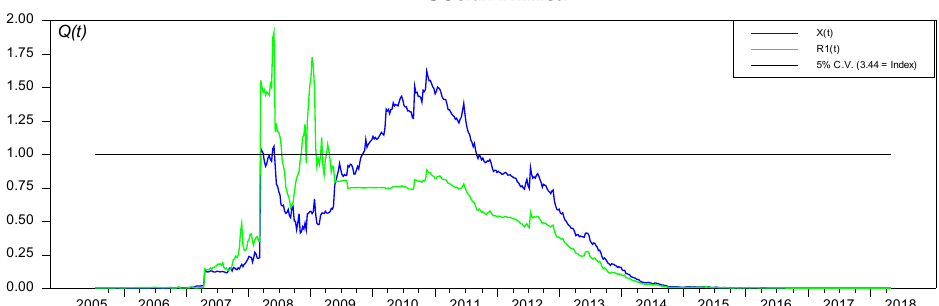
Figure A4. Recursively estimated Parameter Constancy “Known-beta Test”. Note: "X-representation" denotes that all parameters of the cointegrated VAR system are re-estimated during the recursions, while under the "R-representation", only the long-run parameters are re-estimated. The graphs are scaled by the 5% critical value and therefore the null of parameter stability is rejected if the test value exceeds the value of one.